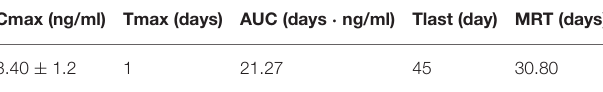
TABLE 1 | Ivermectin pharmacokinetic values in plasma of the experimental Iberian ibexes after the oral administration of a 0.5 mg/kg